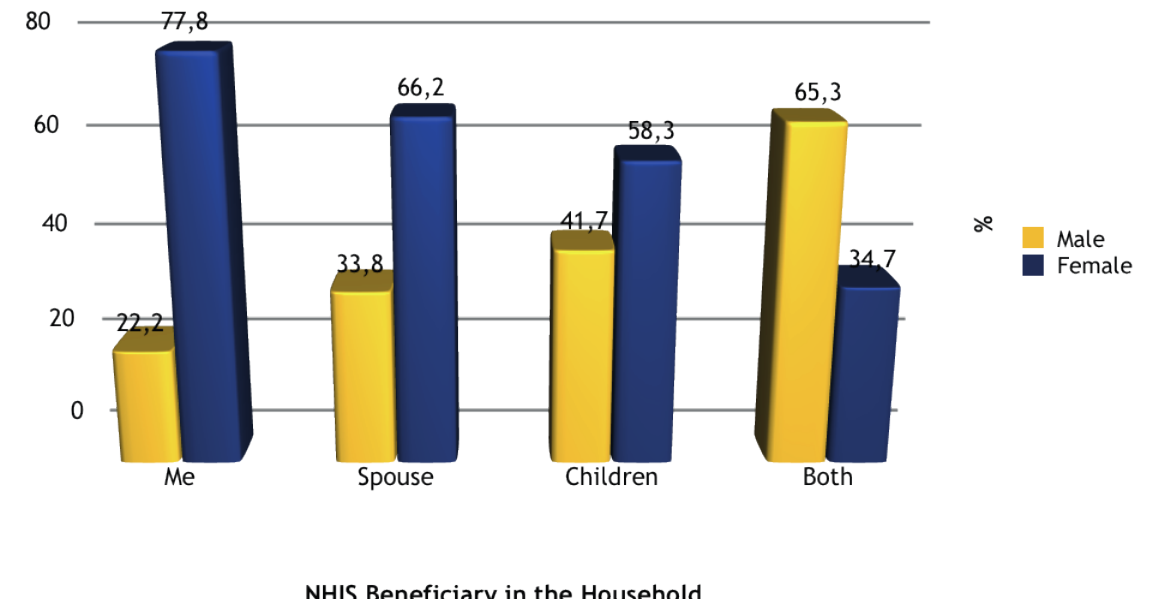
Figure 1. Distribution of respondents by beneficiaries of the NHIS scheme in the household ( n = 337).